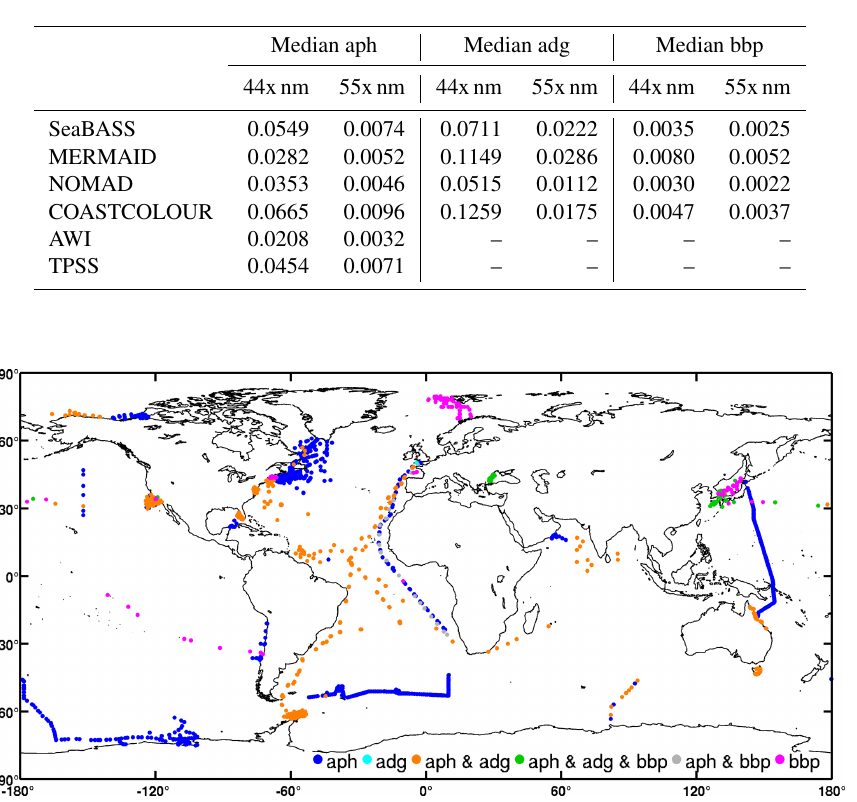
Table 3. Summary of median values for aph, adg and bbp at 44 X and 55 X nm for each dataset (as shown in Fig. 12a–f). Data were first searched for at 445 and 555nm and then with a search window up to 8nm to include data at 547nm.